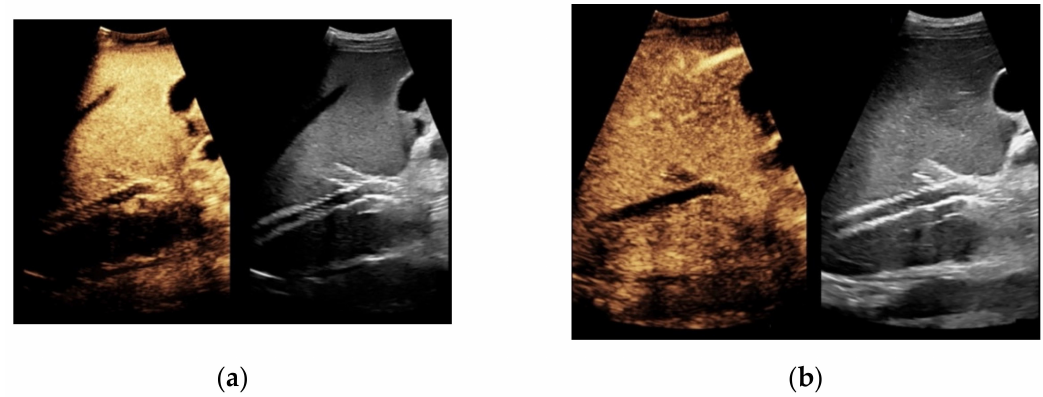
Figure 5. Same patient as in Figure 2. After administration of intravenous contrast, no intraluminal microbubbles can be registered within the transjugular intrahepatic portosystemic shunt compatible with complete occlusion ( a , b ).